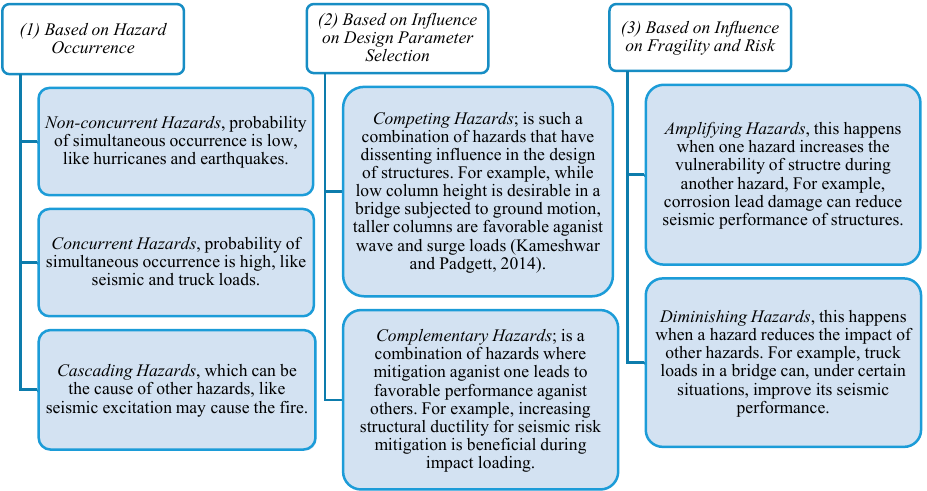
Figure 4. Classification of multi-hazard combinations [26] (modified from Padgett and Kameshwar [25]).